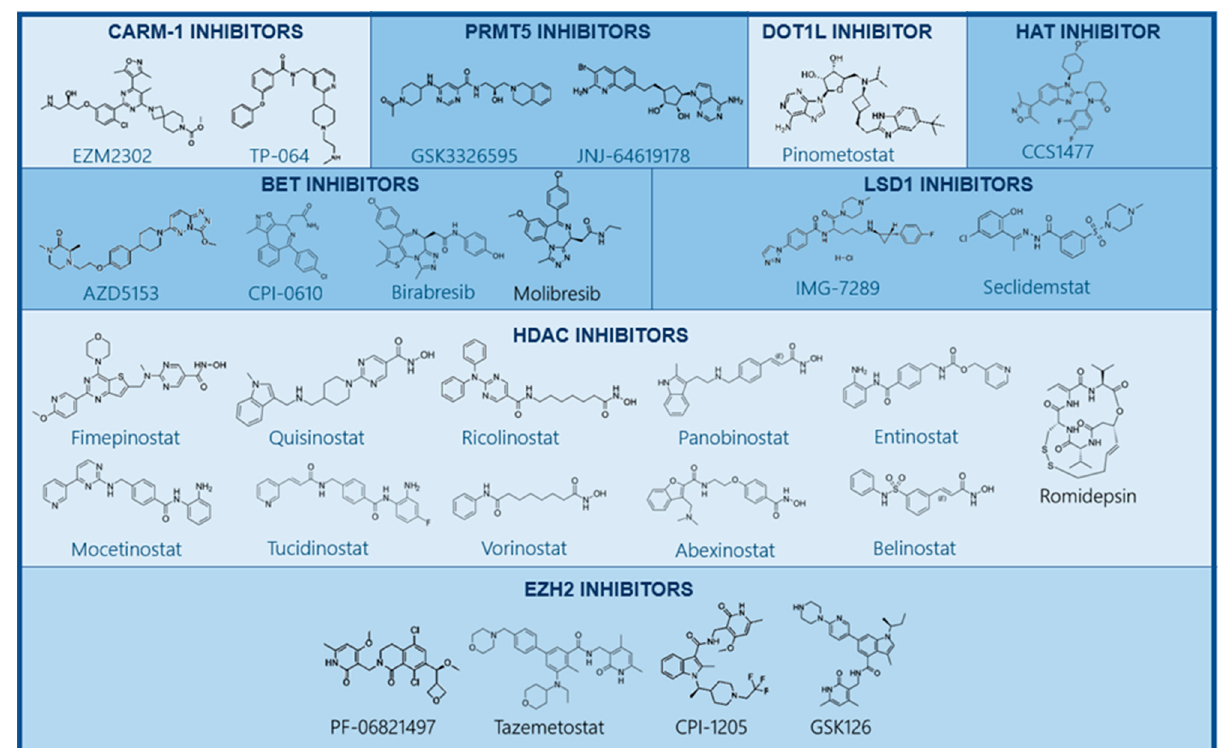
Figure 4. Structure of small-molecule inhibitors targeting epigenetic alterations. Several drugs targeting epigenetic enzymes have been developed and are currently being studied in preclinical and clinical studies. These include small molecules inhibiting CARM-1, PRMT5, DOT1L, EZH2 methyltransferases LSD1, HATs, HDACs, and BET.